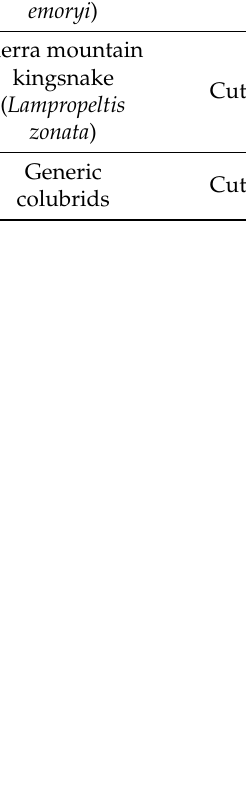
Table 8. Clinical features of chromatophoromas in the reptile family: Viperidae